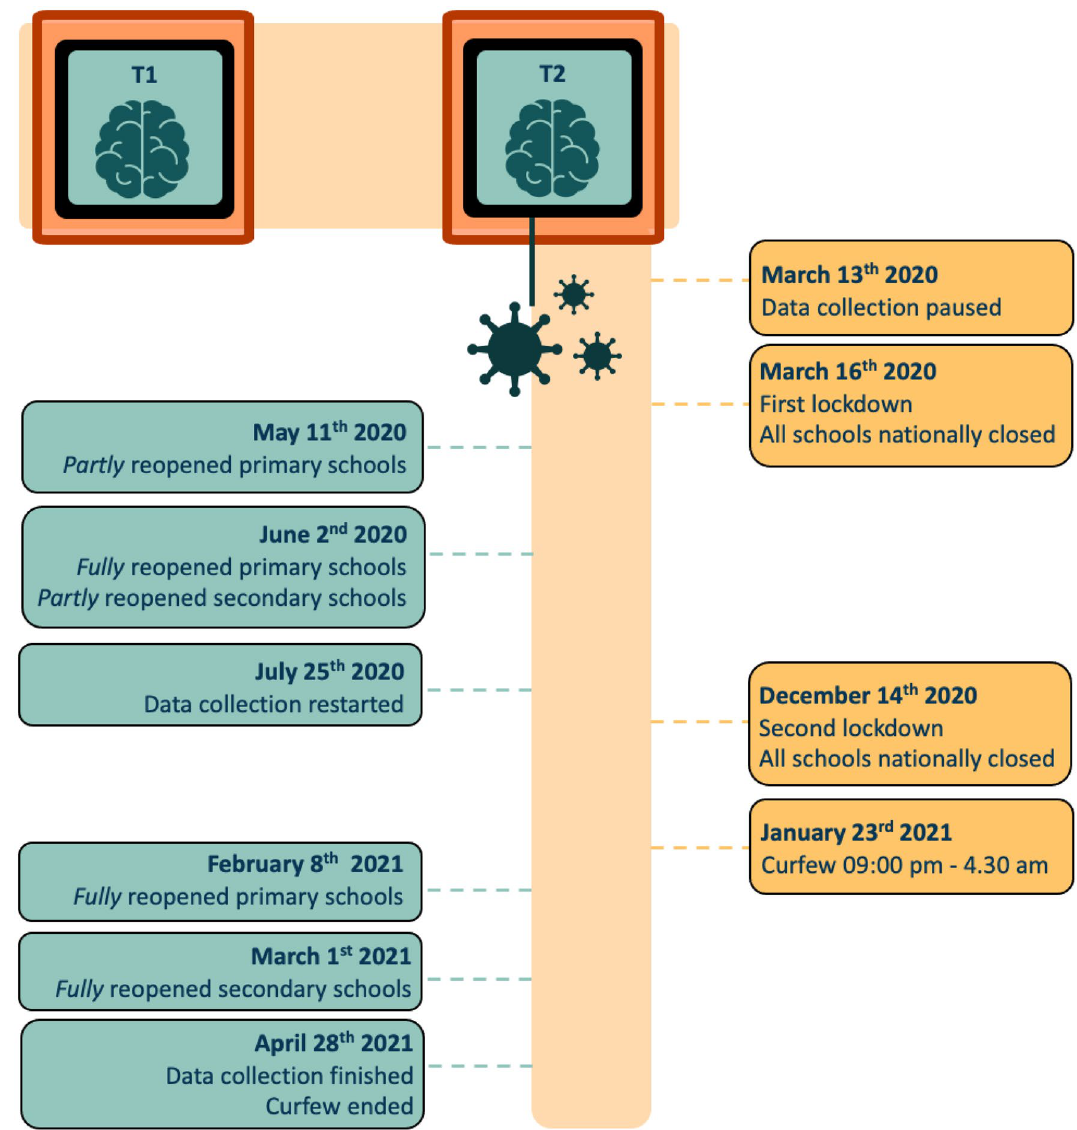
Figure 1. Timeline of COVID-19 pandemic measures in the Netherlands during data collection of MRI time point 2. Note that the strict restrictions of the COVID-19 pandemic are depicted in orange on the right and the more lenient restrictions are depicted in turquoise on the left. T1 = time point 1; T2 = Time point